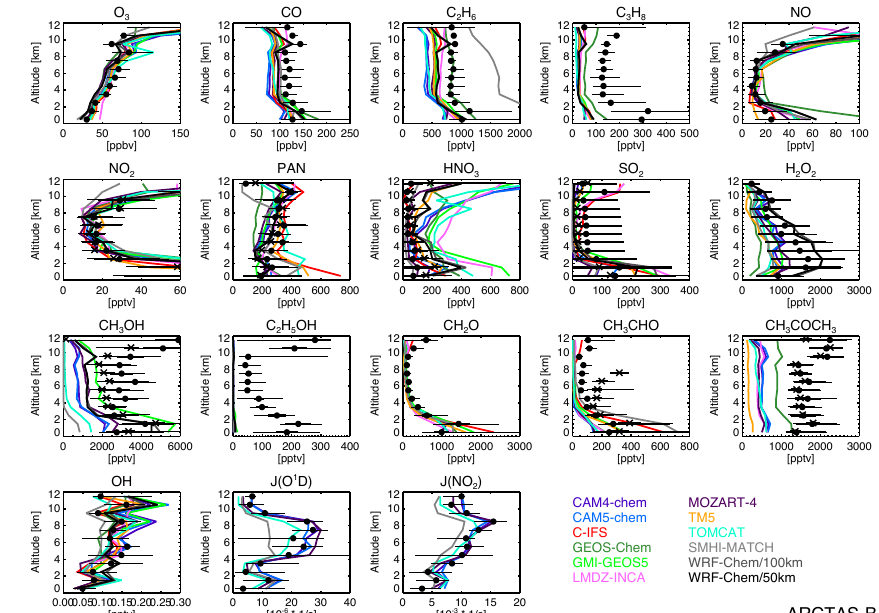
Figure 18. As Fig. 16, for ARCTAS-B DC-8 observations.